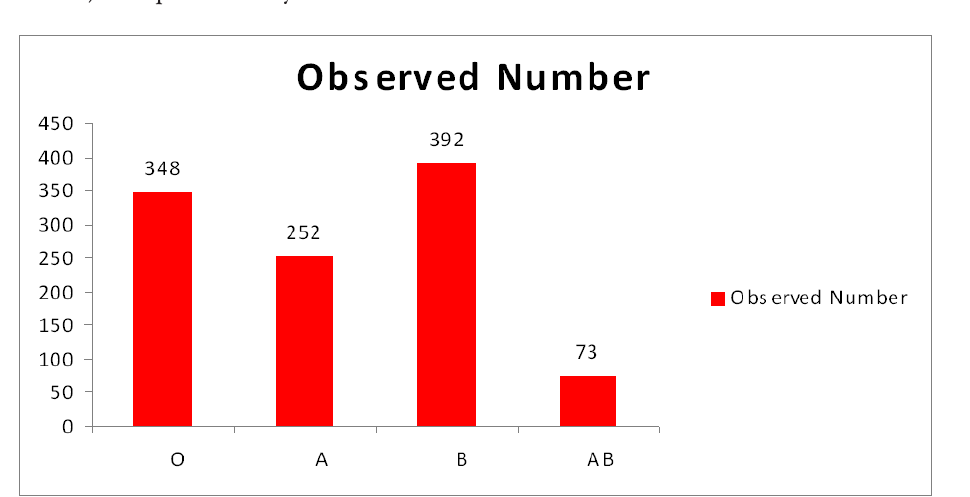
Fig. 1. Phenotypic number of different ABO groups